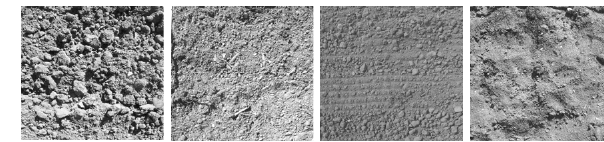
Fig. 2. Shadow analysis of (left to right) sandy clay loam soil tilled with chisel, tiller and roller, and